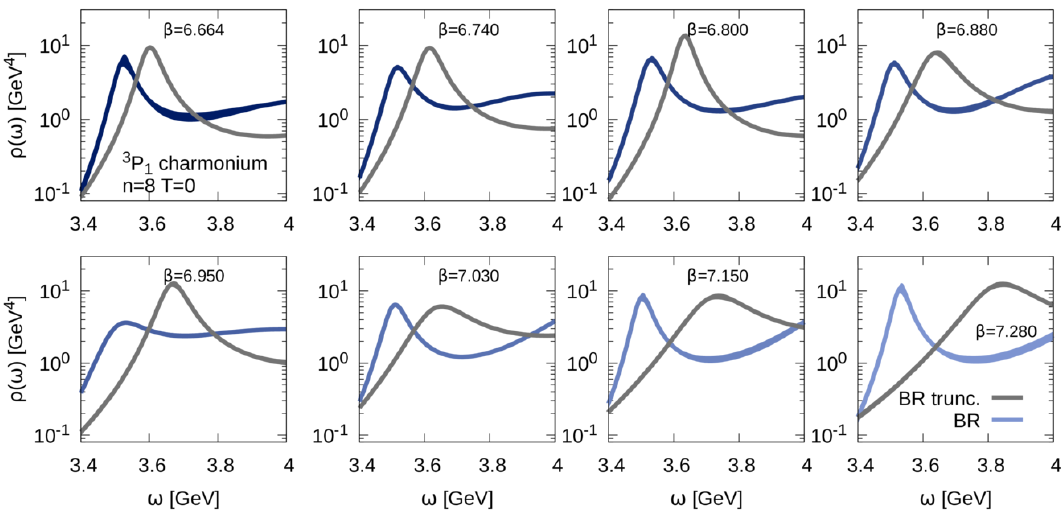
Figure 38 . In(cid:13)uence of truncating the low-temperature simulation data to the same (cid:28) max =a (cid:28) = 12 Euclidean time extent available at (cid:12)nite temperature for charmonium 3 P 1 channel. The full reconstruction is given by colored solid lines, while the result after truncation is given by the gray solid